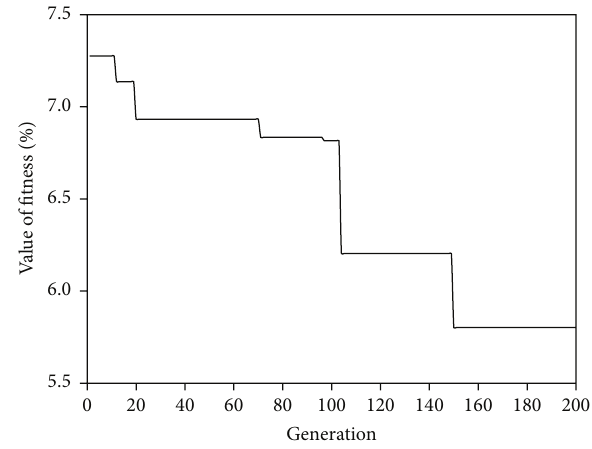
Figure 2: The fitness value in each generation.